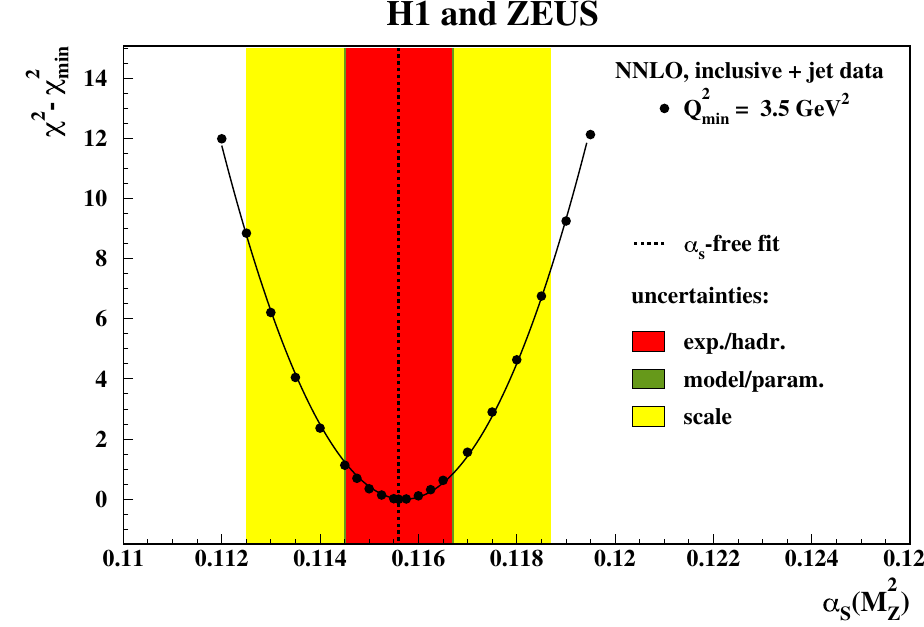
) for HERAPDF2.0Jets NNLO fits with fixed α versus α s ( M 2 Z min ) are also shown, added in Z